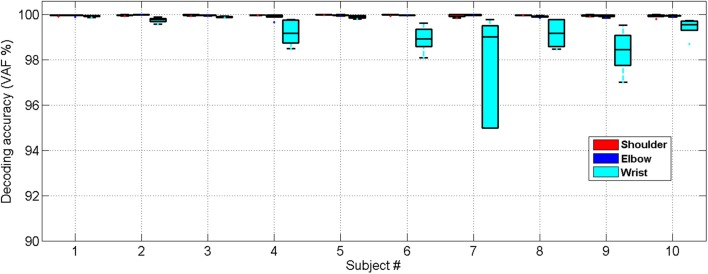
Cross-validated position decoding performance characterized by the VAF over all subjects post stroke.